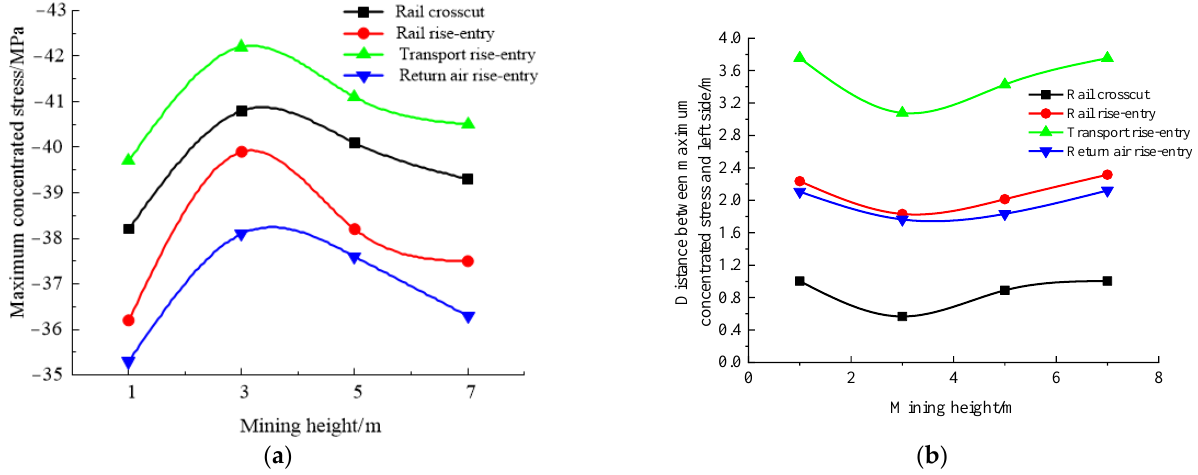
Figure 13. Maximum concentrated stress and its location monitoring results under different mining height conditions. ( a ) Maximum concentrated stress, ( b ) Position of maximum concentrated stress.